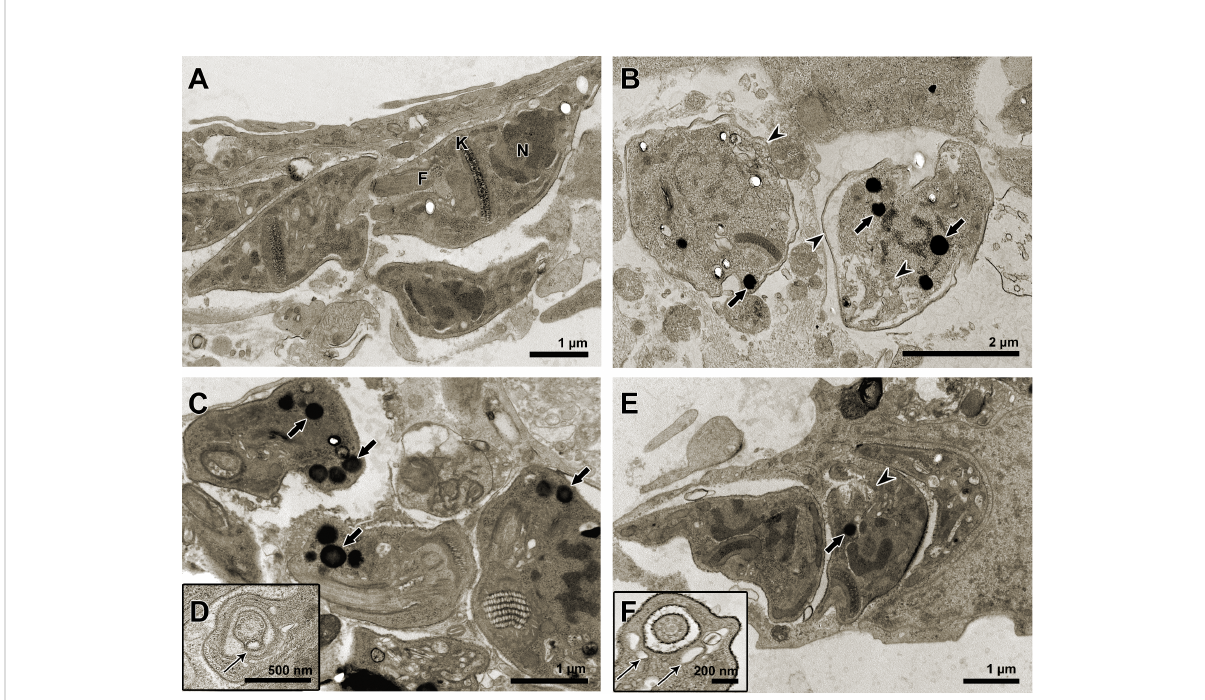
FIGURE 7 Transmission electron microscopy of T. cruzi intracellular forms treated for 72 h with Bz, AMD or their combination, showing the predominance of the phenotype generated by AMD in the combination Bz + AMD. (A) Untreated parasites exhibiting organelles with typical morphology; (B) Bz (IC 50 /72 h = 5.4 m M); (C, D) AMD (IC 50 /72 h = 2.5 m M) and (E, F) Bz:AMD (Bz: IC 50 /72 h = 1.3 m M; AMD: IC 50 /72 h = 2.5 m M). Black thin arrows indicate the presence of vesicles in the fl agellum and fl agellar pocket; black arrows indicate accumulation of lipid bodies; arrow heads indicate vacuolization and disorganization of the cytoplasm. N, nucleus; K, kinetoplast; F, fl